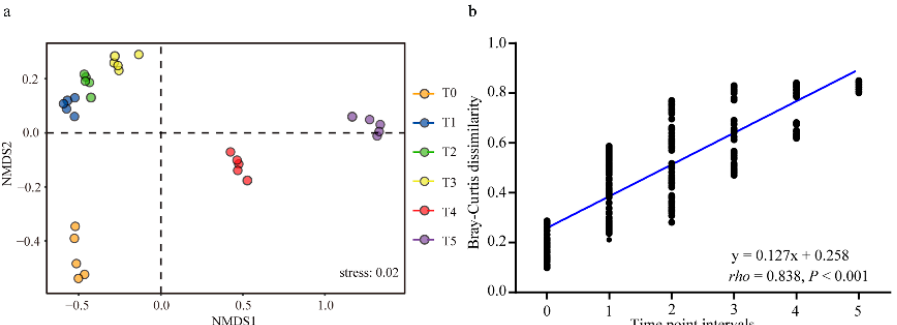
Figure 2. Non-metric multidimensional scaling (NMDS) plot ( a ) and the relationship between dissimilarity and time point intervals ( b ) based on Bray–Curtis distance. The regression slope indicates the turnover rate. The rho indicates Spearman’s rank